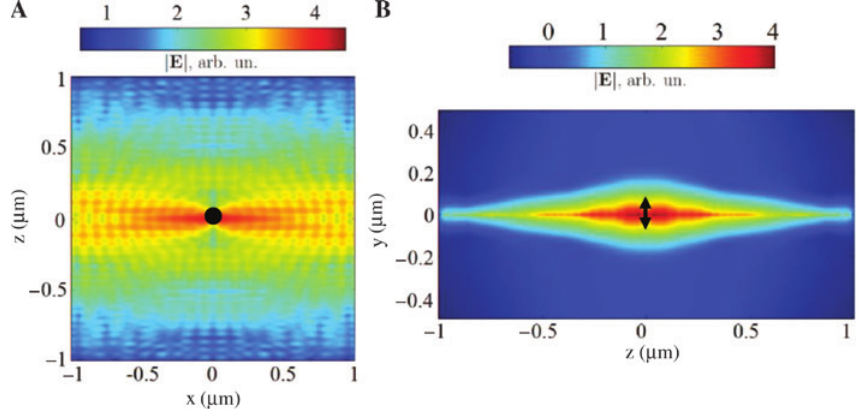
Figure 9: Directional surface plasmon polaritons on anisotropic black phosphorus (BP). Field intensity distribution excited by a y -directed dipole current source on a 10-nm-thick BP layer with doping level 10 × 10 13 /cm 2 at f = 92.6 THz. (A) In-plane field distribution and (B) vertical out-of-plane field distribution, dominated by the response of a surface plasmon polariton mainly directed along the x -axis and tightly confined on the surface. Both figures are calculated with a commercial FDTD solver. The black dot/arrow indicates a y -polarized dipole. Adapted with permission from Ref.